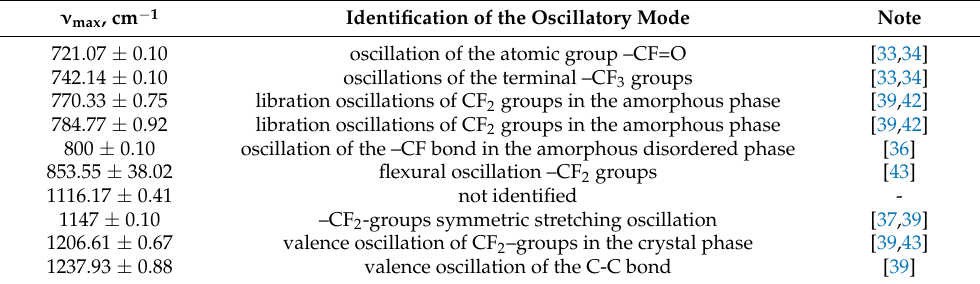
Table 2. Positions of maxima ( ν max , cm − 1 ) of vibrational modes registered in spectral ranges I–V of infra-red spectra of attenuated total reflection of films of thermoradiationally modified polytetrafluo- rethylene, irradiated with xenon ions with energy ~1